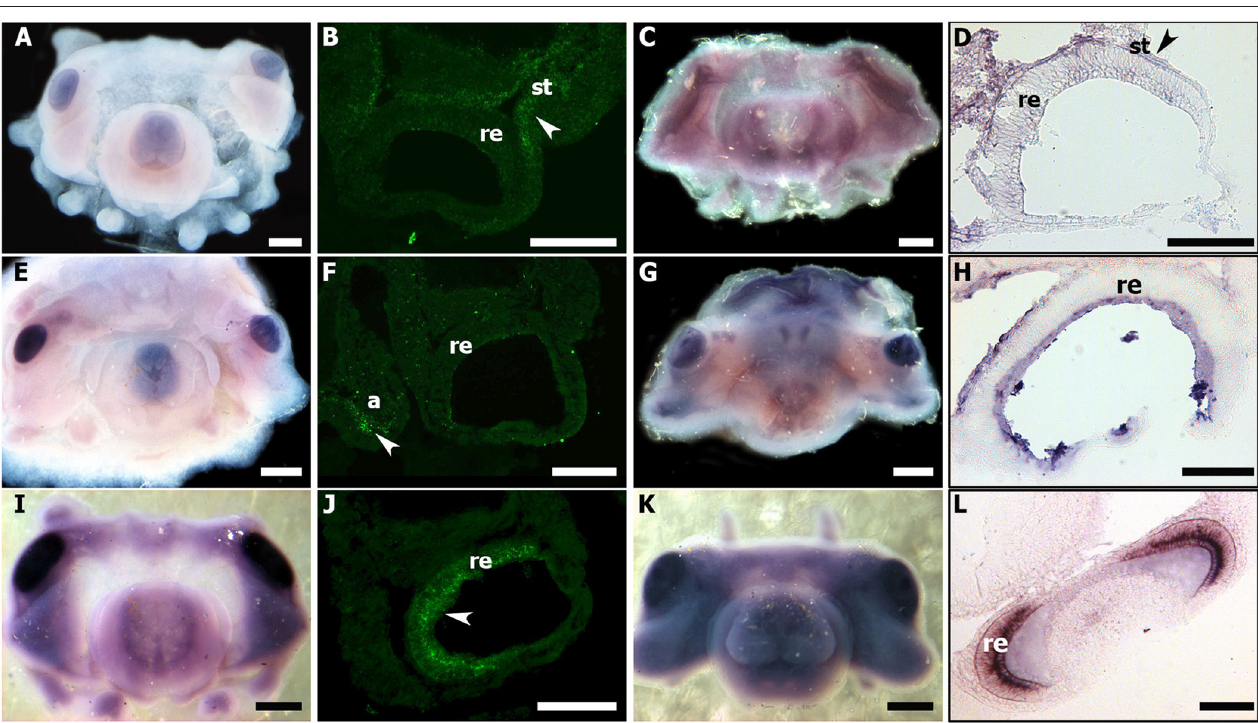
FIGURE 7 | Sof-eya, Sof-dac, and Sof-otx expressions during stage 20 and 21 of S. officinalis. (A–D) : Sof-eya . (E–H) : Sof-dac . (I–L) : Sof-otx . (A,E,I) : embryos stage 20. (B,F,J) : thin sections of stage 20. White head arrows point expressions of genes. (C,G,K) : embryos stage 21. The pink color in eyes and around the eyes is background: no staining is visible through sections (D,H,L) [thin sections of embryos (C,G,K) , respectively]. a: arms; re: retina; st: surrounding tissue. (A,C,E,G,I,K) : scale bar is 500 µ m. (B,D,F,H,J,L) : scale bar is 150 µ